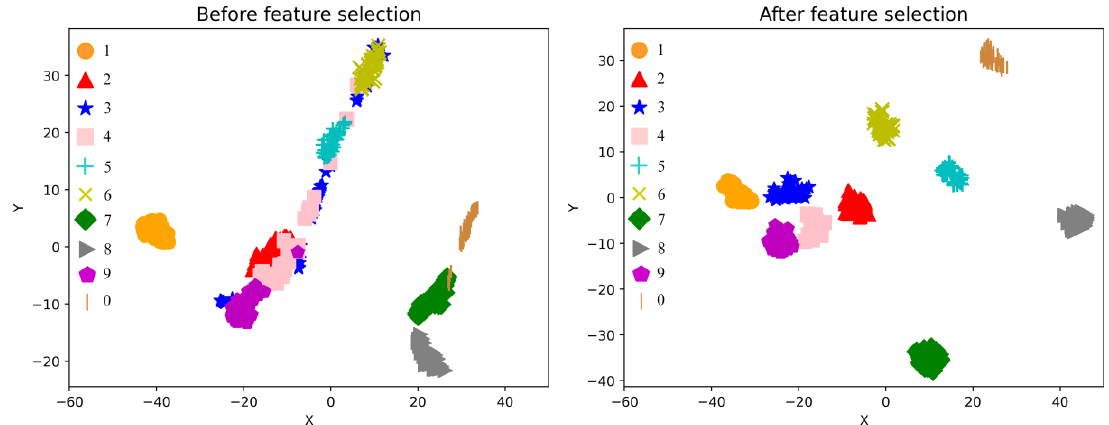
Figure 11. Two-dimensional distribution map of t-SNE.